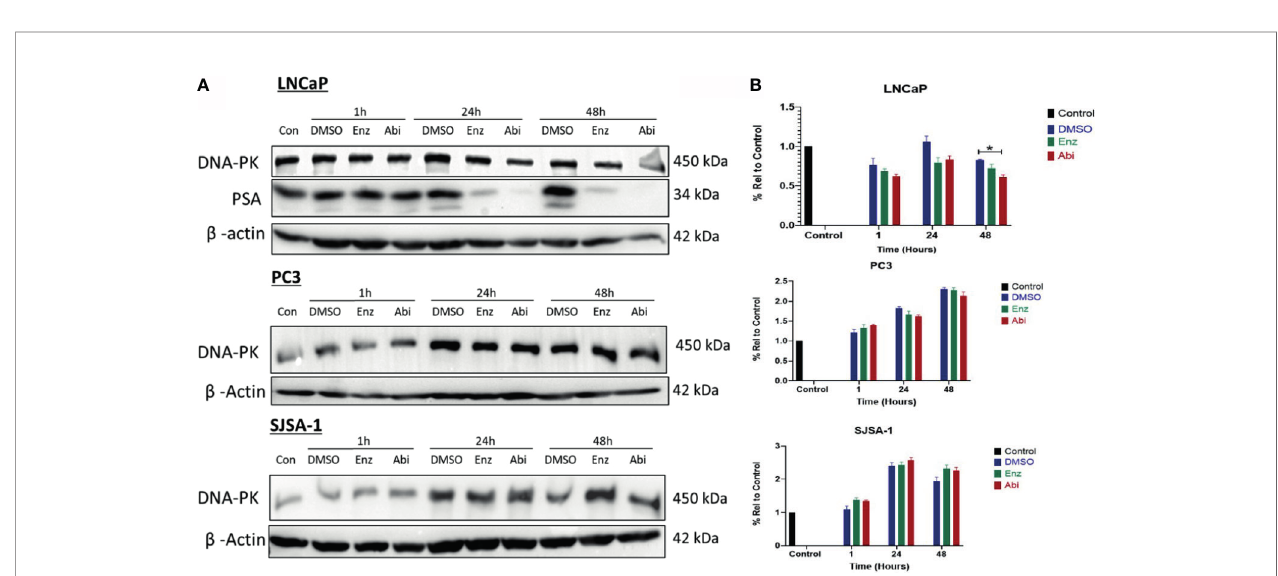
FIGURE 9 | Impact of Abiraterone and Enzalutamide on DNA-PK and PSA protein expression in AR-sensitive LNCaP and AR-insensitive PC3 prostate models and osteoblastic bone model SJSA-1. All models were treated with 10 m M Abiraterone, Enzalutamide or DMSO. Samples were then harvested 1, 24 and 48 hours post- treatment and expression levels measured via Western blot (A) and densitometric analysis (B) . b -Actin was used as a loading control. (n=3). Unpaired students t-test was used for comparisons between two groups *p < 0.05 and error bars represent